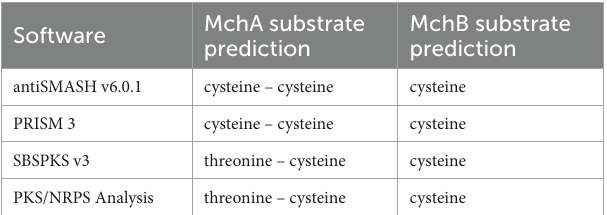
TABLE 2 Comparison of substrate prediction for the NRPS enzymes of the mch gene cluster by four different software. MchA substrate MchB substrate Software prediction prediction antiSMASH